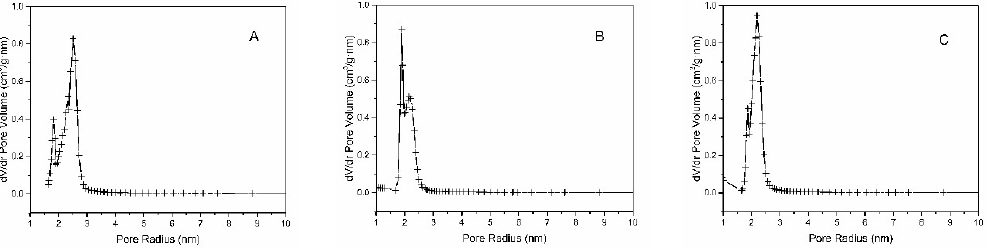
Figure 3. BJH pore size distribution for nanomaterials SBA-15 ( A ), nSBA-15 ( B ) and cSBA-15 ( C ) shows decrease in radius after modification step.